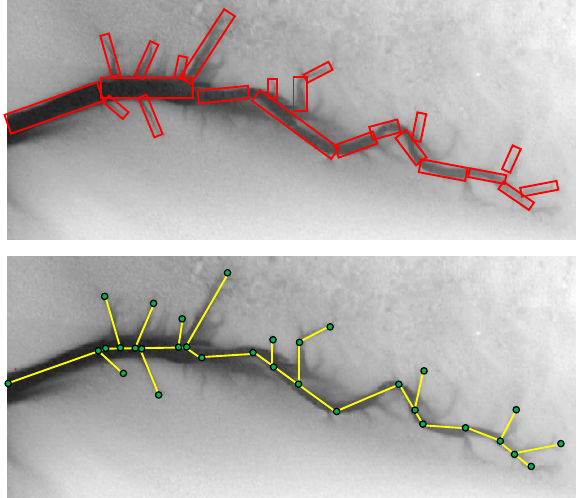
Figure 1. Outline of our proposed method: (1) the fitting of rectangles to the data by using a sampling process and (2) the construction of a network